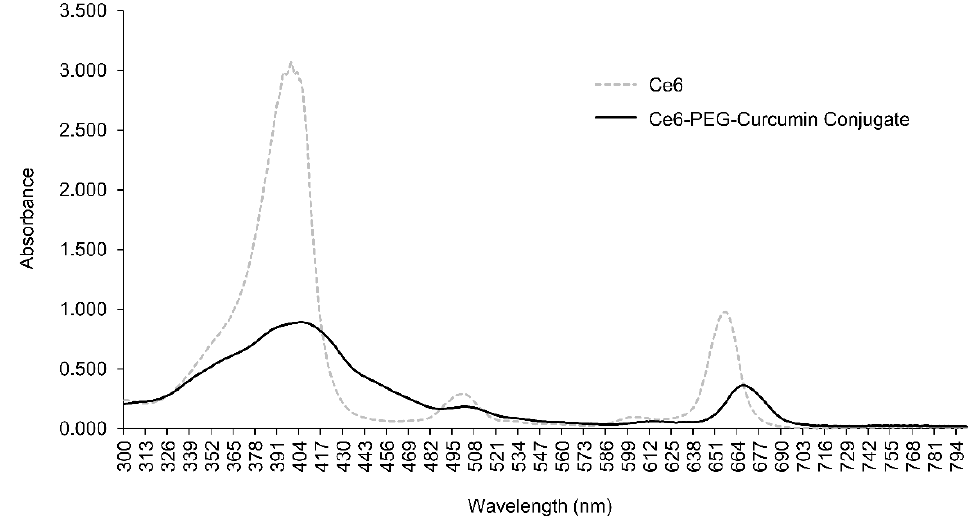
Figure 1. Absorption spectrum of Ce6-PEG-curcumin conjugate. with and without light (Table 1). The EC 50 values (effective concentration for 50% inhibition of the radicals) of scavenging ABTS radicals for Ce6-PEG-Cur without and with LED light irradiation were 18.77 ± 4.55 and 23.31 ± 9.82 µ M, respectively. The antioxidant activity (measured by ORAC assay) of Ce6-PEG-Cur without and with LED light was 34.48 and 27.40 µ M TE scavenging capacity, respectively. The antioxidative capacity was slightly reduced by LED light application in both the ABTS and ORAC assays. Table 1. Antioxidant activity of Ce6-PEG-curcumin with and without light irradiation determined by ABTS and ORAC